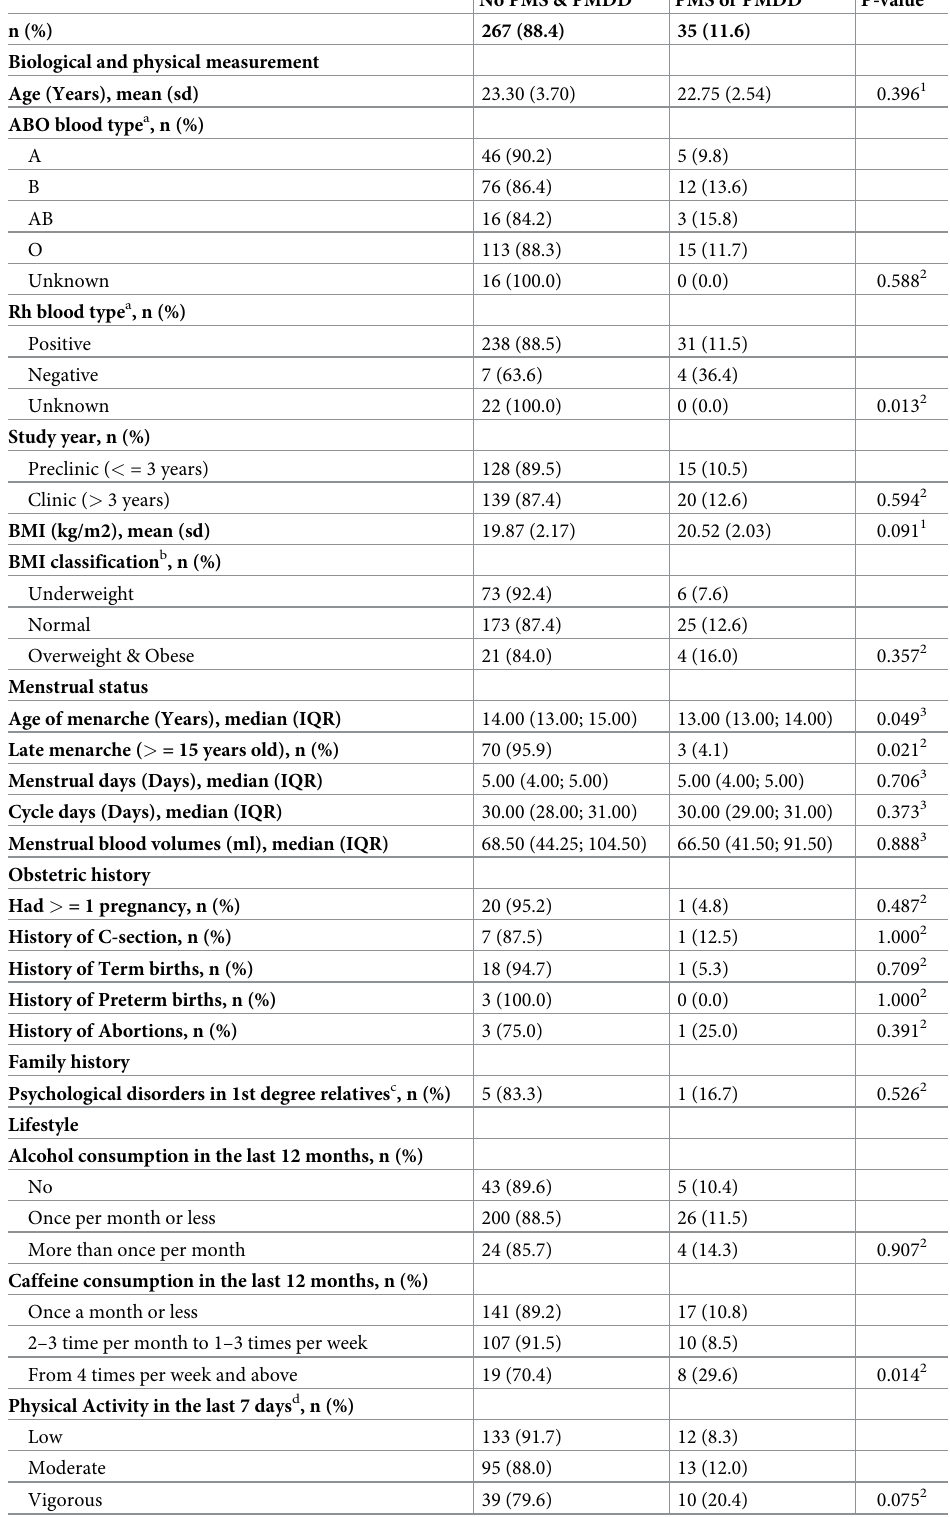
Table 3. Characteristics of participants by PMS/PMDD status according to the C-PASS